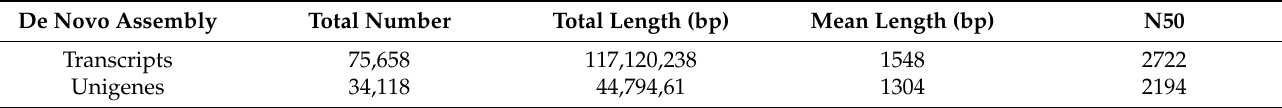
Table 2. Assembly statistics from D. provosti